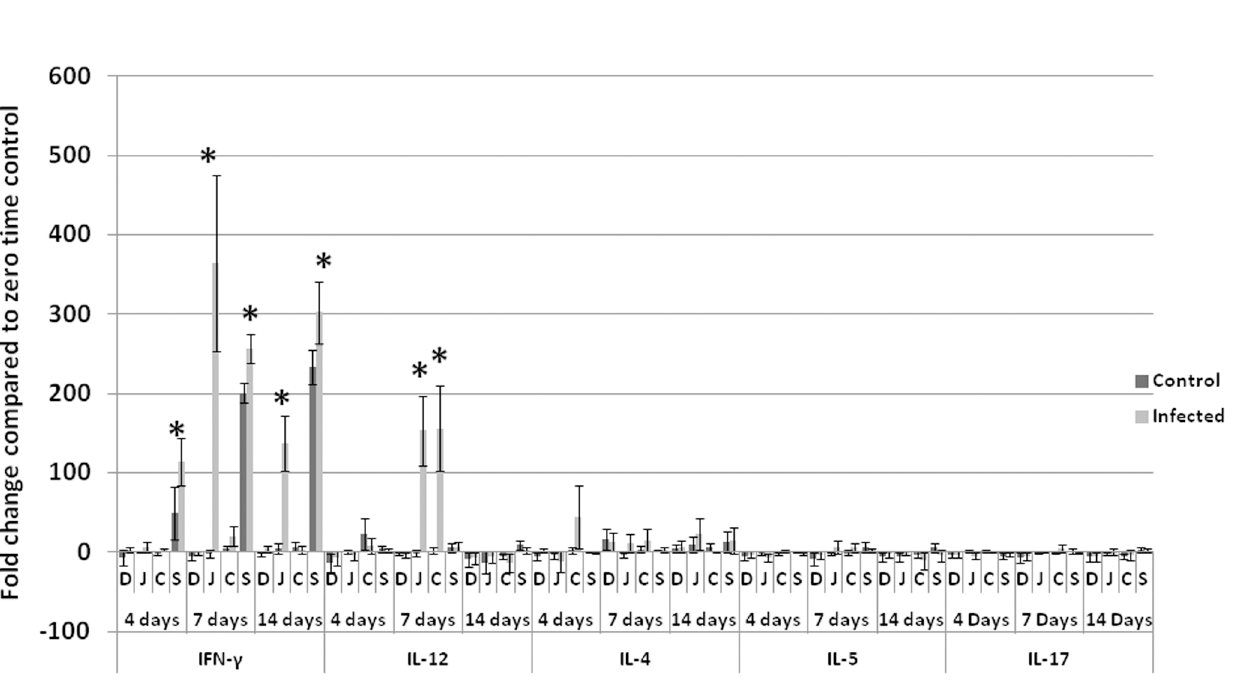
Fig 4. Fold changes in Th1, Th2 and Th17 cytokines observed in turkeys. Significant elevation of Th1 cytokine IFN- γ was observed in the jejunum of infected birds at 7 and 14 dpi and in spleen at 4, 7 and 14 dpi. The other Th1 cytokine, IL-12, shows significant elevation in jejunum and cecum of infected birds at 7 dpi. Th2 (IL-4 and IL-5) and Th17(IL-17) are not significantly different at P < 0.05. D : duodenum, J : jujenum, C : cecum, S spleen, Days refers to days post inoculation (dpi). Analyses were performed in duplicate (Five turkeys/group at each time point) and values are mean ± 3SD. * Differences between infected group and non-infected groups within the same organ are significant (P < 0.05).